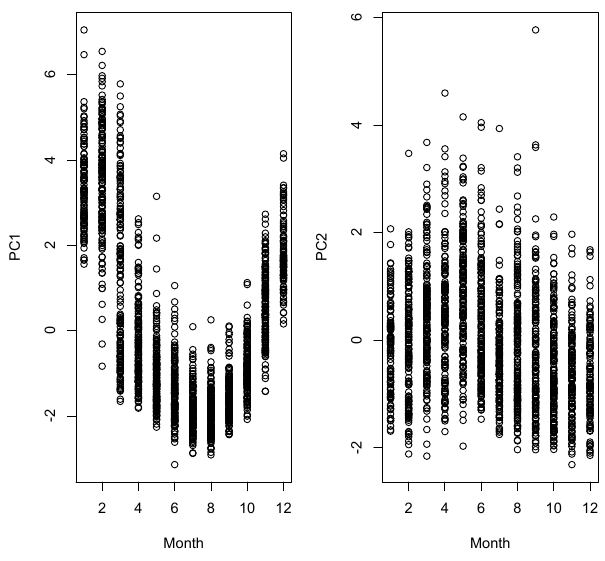
Fig. 6. Plot of PC1 (left) and PC2 (right) vs. month of the